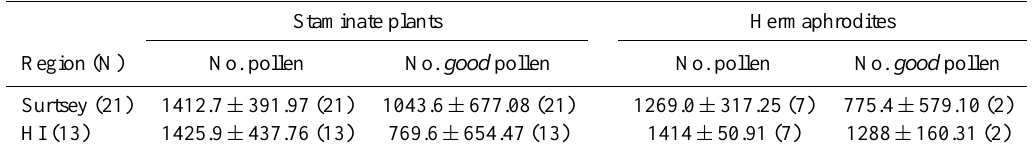
Table 3. Average number of pollen grains (total) and number of presumed functioning ( good ) pollen grains per anther ( ± SD). Number of individuals is included in